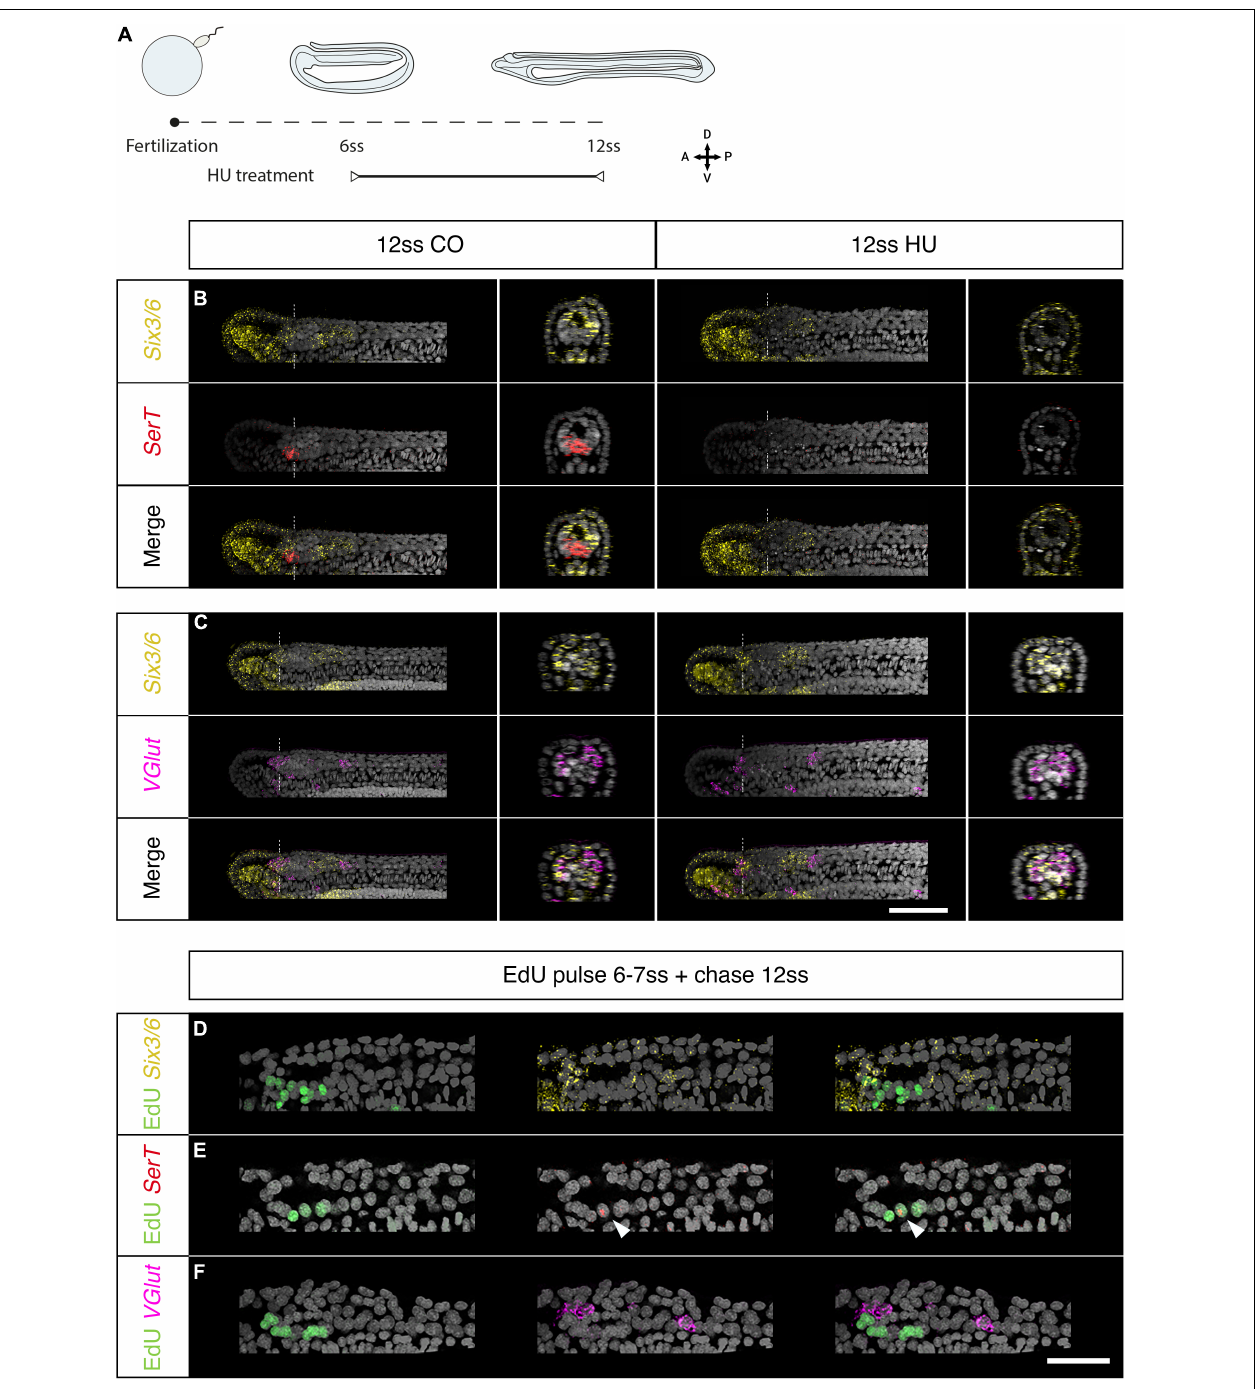
FIGURE 4 | Brain proliferation is required to establish the neuronal type repertoire in the amphioxus larva. (A–C) Expression of neurotransmitter markers in control and Hydroxyurea (HU)-treated embryos at 12 ss through HCR. (A) Experimental design of HU treatments. (B) SerT expression in control embryos is localised at the border of the anterior Six3/6 domain but disappears following HU treatment. (C) In the neural tube, VGlut is expressed in anterior-most cells within the anterior Six3/6 domain and caudal to the posterior Six3/6 domain. This pattern remains the same in HU-treated embryos. Scalebar is 50 µ m. (D–F) Brain expression of neurotransmitter markers in embryos pulsed with EdU at 6–7 ss and chased to 12 ss. (D) EdU is detected in a few cells within the anterior Six3/6 domain. (E) SerT -positive neurons are labelled with EdU. (F) VGlut expression is not detected in EdU-positive cells. Scalebar is 30 µ m. Six3/6 in yellow, SerT in red, VGlut in magenta, EdU in